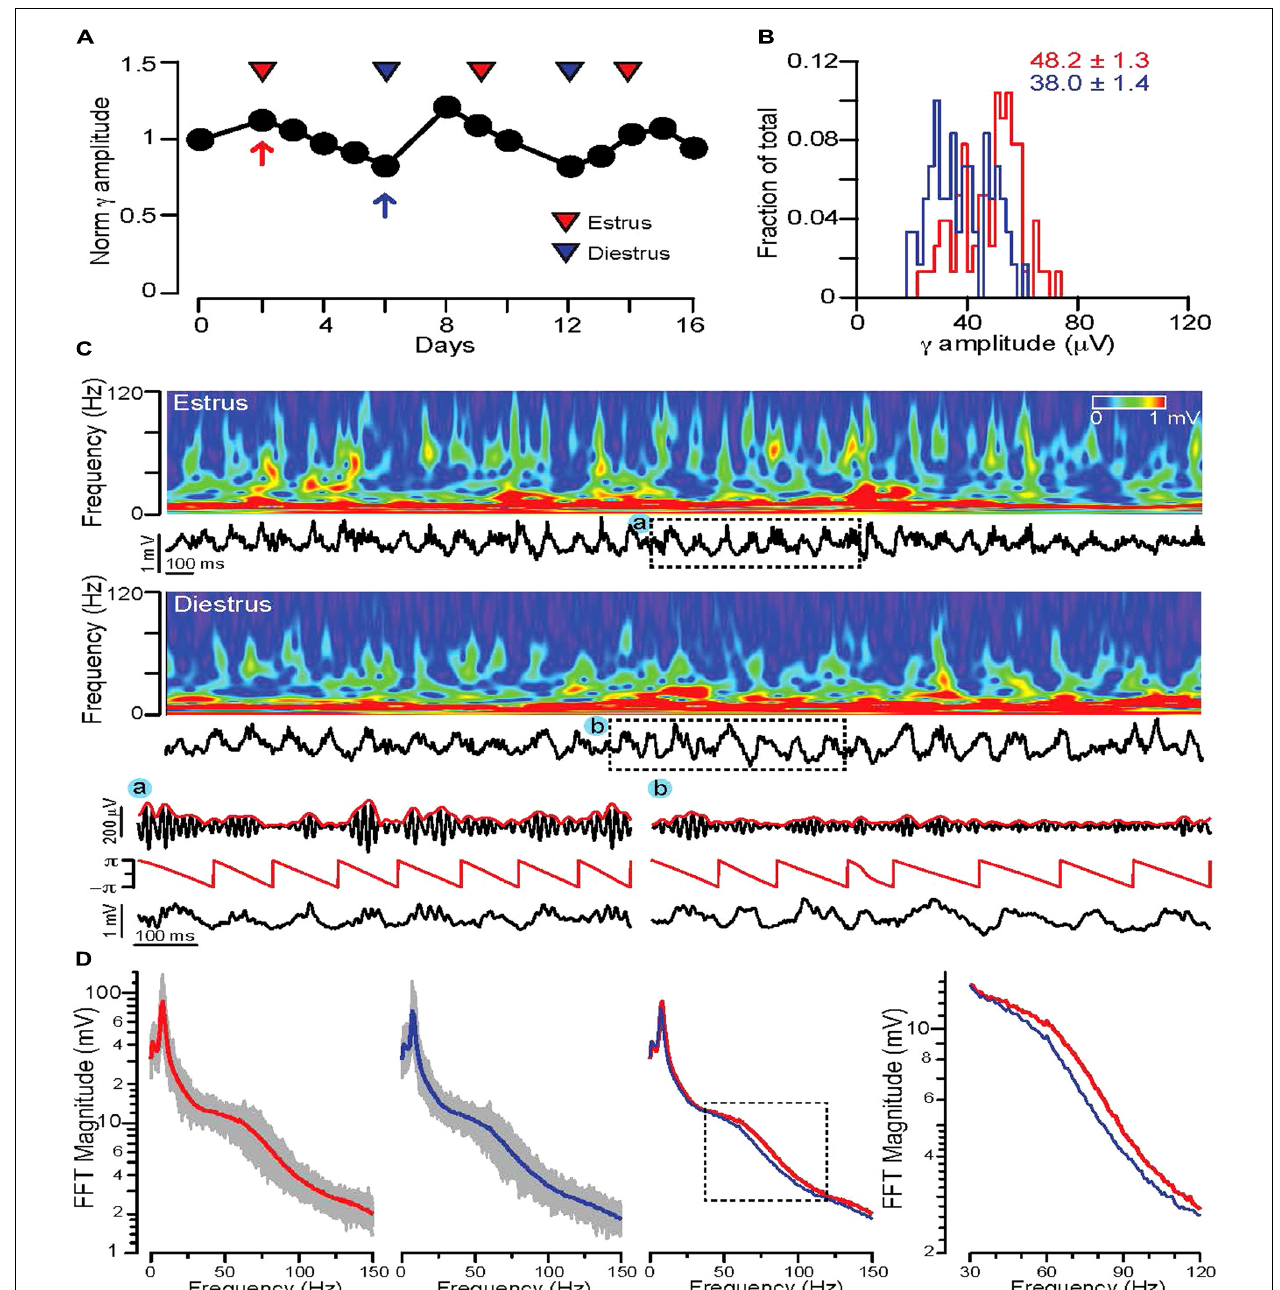
dashed rectangles. Below : Hilbert phases of the θ (5–12 Hz) frequency range, filtered trace in the γ frequency range (63–120 Hz, black) with the corresponding Hilbert magnitudes (red). (D) FFT spectra of local field potential recordings of all REM phases during an estrus (leftmost diagram) and a diestrus day (second from left). Gray traces indicate the FFT spectra of individual REM phases, thick lines are the average FFT spectra on an estrus (red) or diestrus (blue) day. Third diagram from left shows the superimposed two average FFT spectra (estrus: red, diestrus: blue) for comparison. The area marked by dotted lines is enlarged on the diagram on the right to show the segments of the average FFT spectra where the largest deviation appears in γ activity. For the detailed explanation of the applied calculations please refer to the Sections “Materials and Methods,” and “Electrophysiology Data